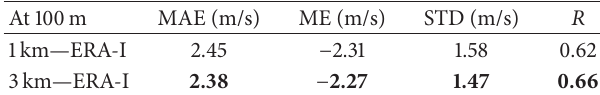
Table 2: Statistical metrics (MAE in m/s, ME in m/s, STD of the ME in m/s, and 𝑅 ) for the 100m wind speed, so as to evaluate the performance of different horizontal resolutions (3 km versus